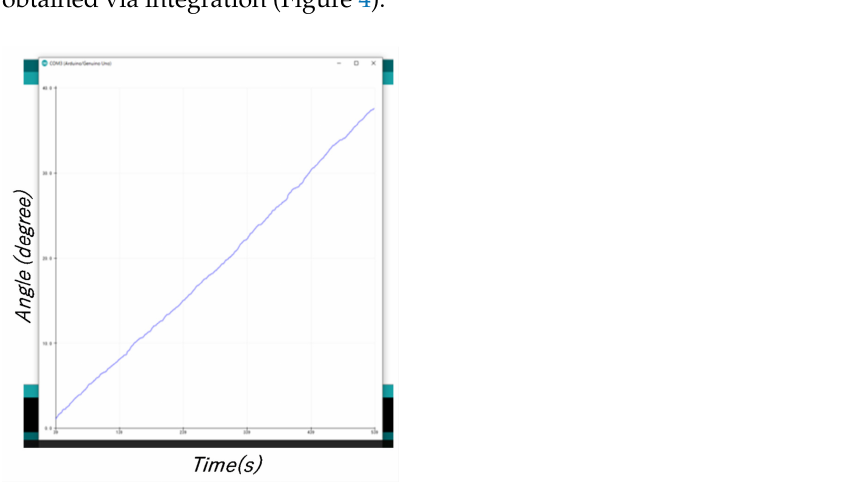
Figure 4. Angle detection only using a gyroscope sensor (when the robot was